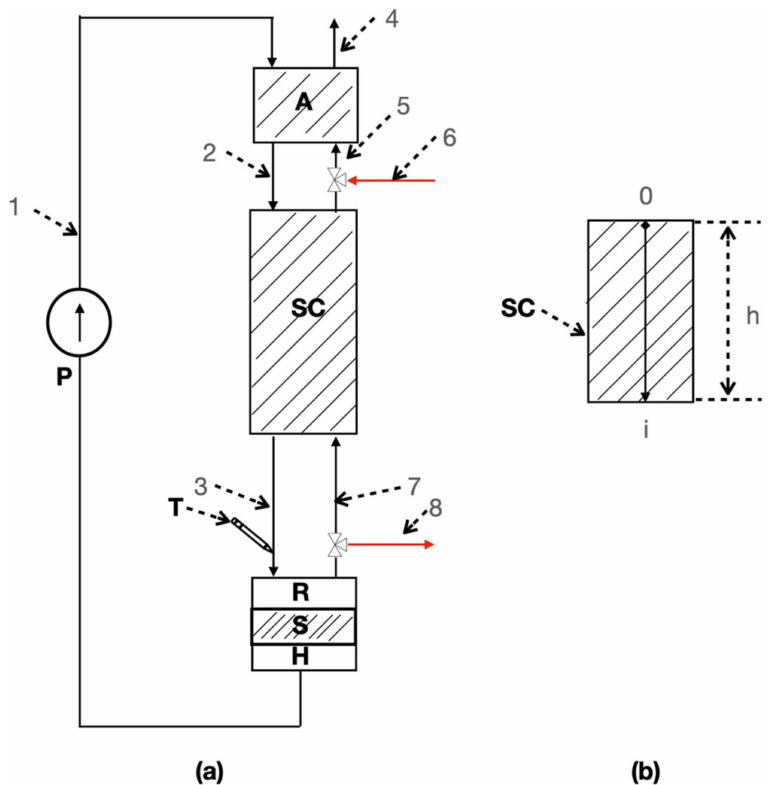
Figure 1. ( a ) The 13 C isotope separation laboratory plant; ( b ) The 0 i